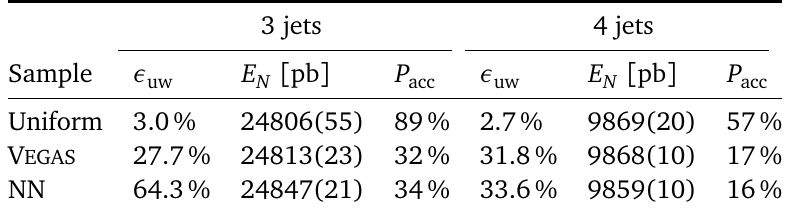
Table 2: Results for sampling the total cross section for gluonic jet production at (cid:112) s = 1TeV, i.e. the Monte Carlo integral E is an estimator for σ . Besides E N N gg → n jets and its MC error, we also show the unweighting efficiency ε of the sample, com- uw paring V EGAS optimisation, NN-based optimisation and an unoptimised (“Uniform”) distribution. All samples consist of N = 10 6 points with non-zero weights. The table also lists the acceptance rate P . acc 3 jets 4 jets [ pb ] ε E Sample ε N uw uw